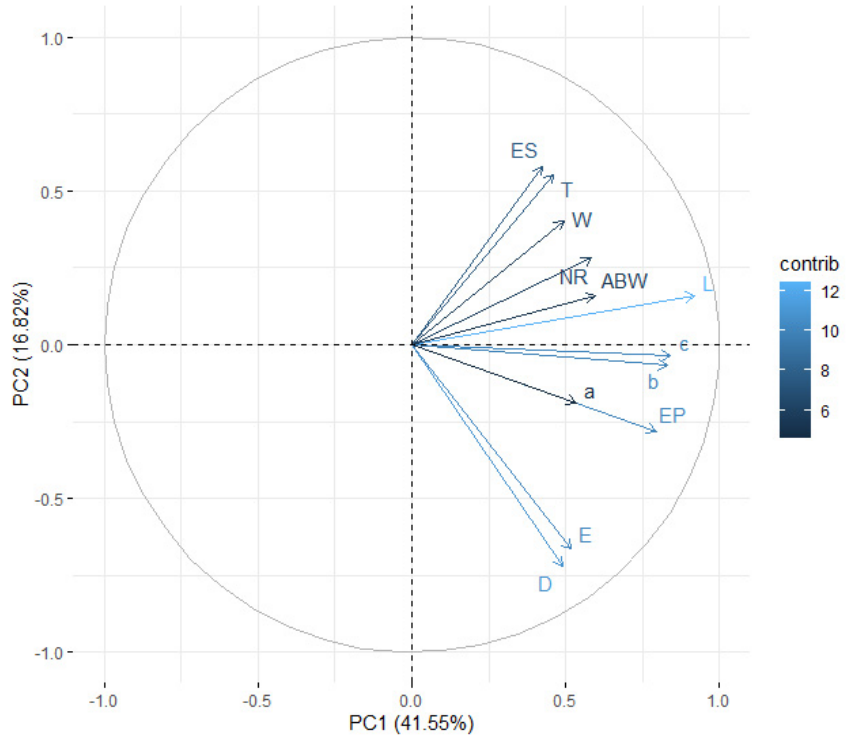
Figure 3. Principal component analysis of morphometric variables for infective juveniles.